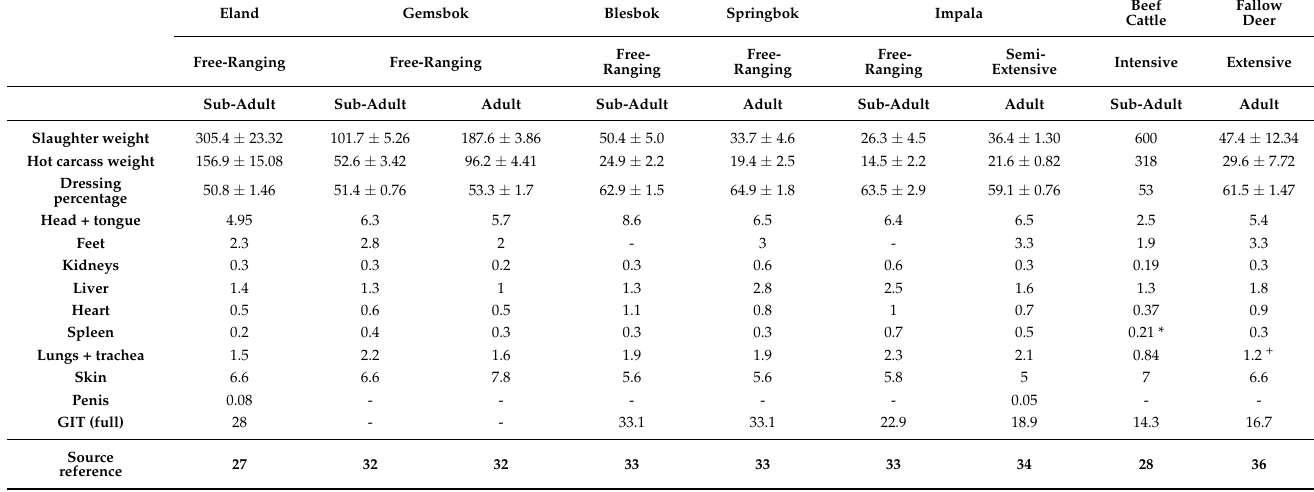
Table 4. Summary of previously reported offal yields (as a % of live weight at slaughter) of different antelope species commonly used for meat production under different husbandry systems, against that of beef cattle. Data extracted from Needham et al. [27], Hoffman et al. [32], Van Zyl et al. [33], Needham et al. [34], AHDB [28], and Fitzhenry et al. [36]. Only data for male animals are summarized. Reported standard deviations are given where